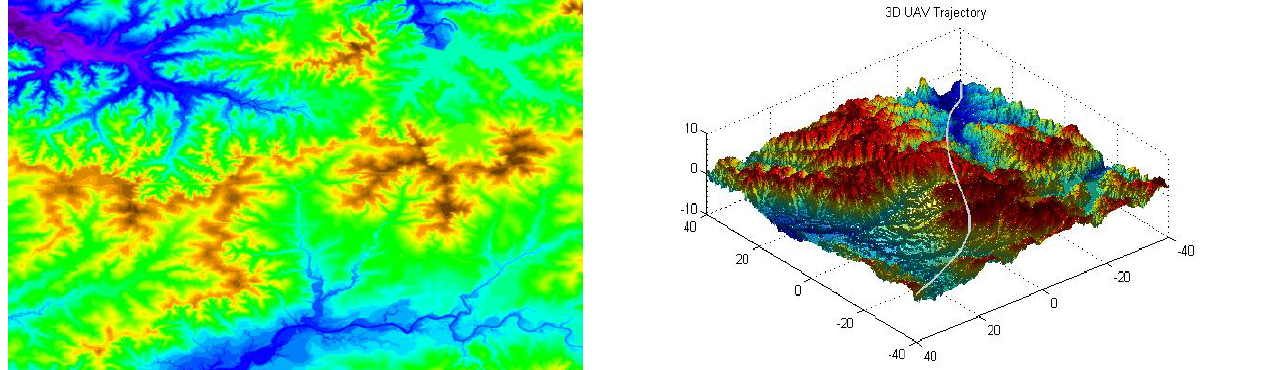
Figure 9. Illustration of the final generated optimal UAV trajectory based on NICA planner algorithm(left: NW-SE ,right: